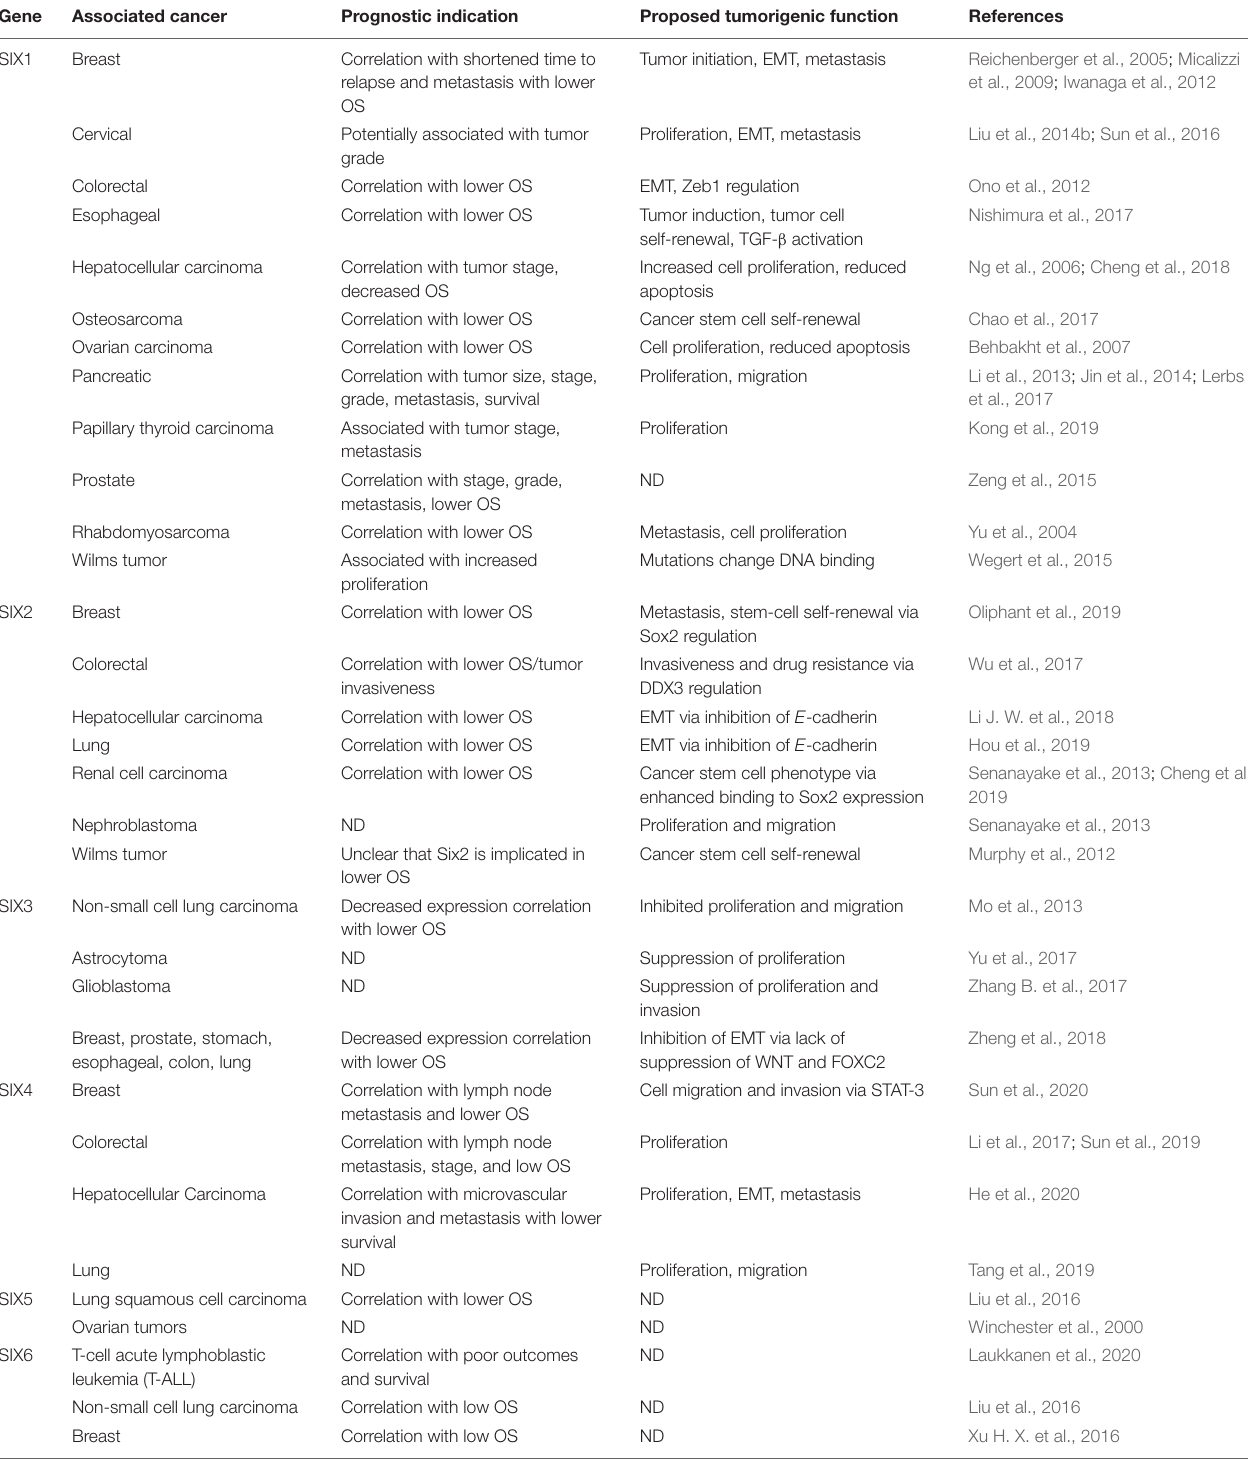
TABLE 2 | SIX transcription factors in cancer